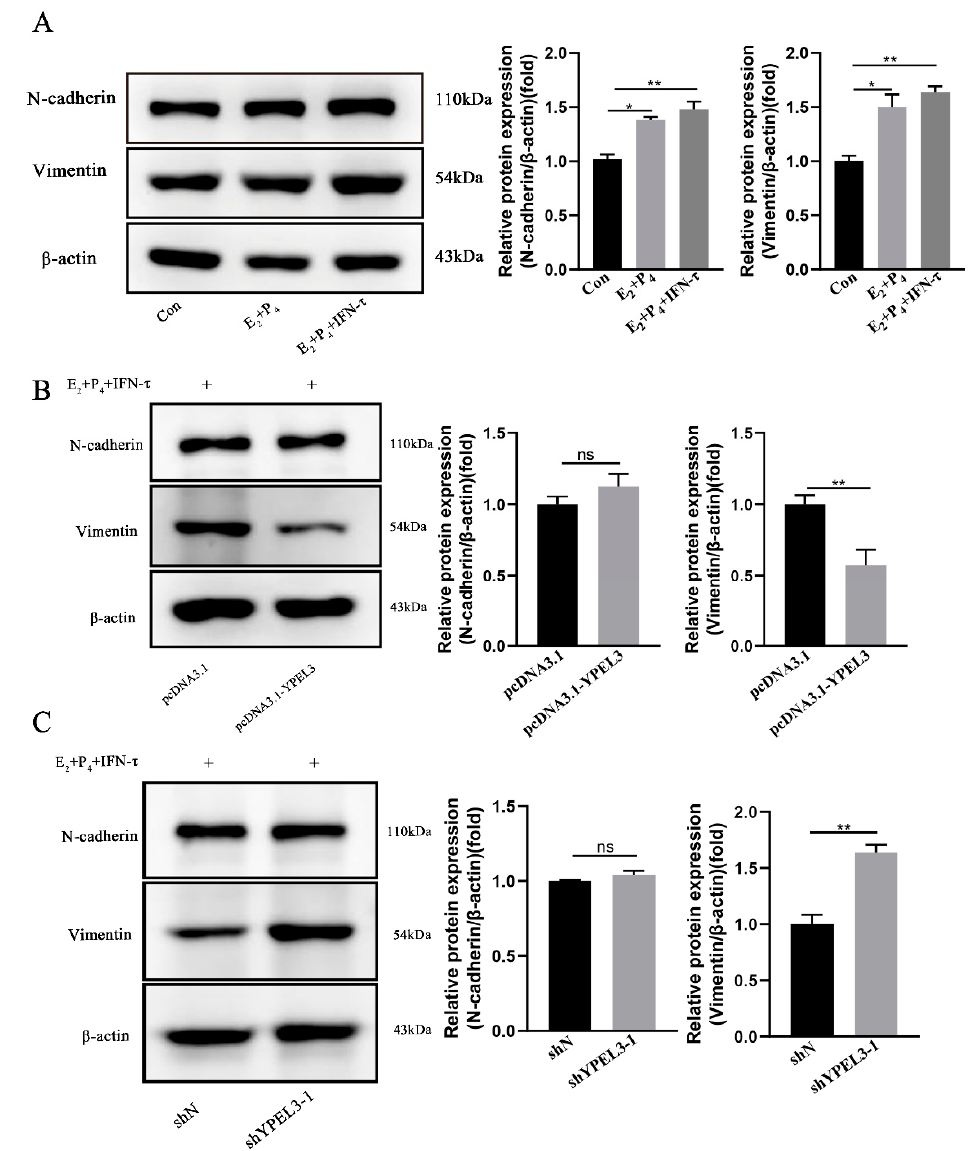
Figure 4. The effect of YPEL3 on EMT marker expression in gEECs. ( A ) Western blot analysis of the EMT marker proteins N-cadherin and vimentin after treatment with or without E 2 , P 4 and IFN- τ . Western blot analysis of the EMT marker protein expression in gEECs with silencing ( B ) and overexpression ( C ) of YPEL3 and treated with E 2 , P 4 and IFN- τ . * p < 0.05, ** p < 0.01, ns, not significant ( p > 0.05).